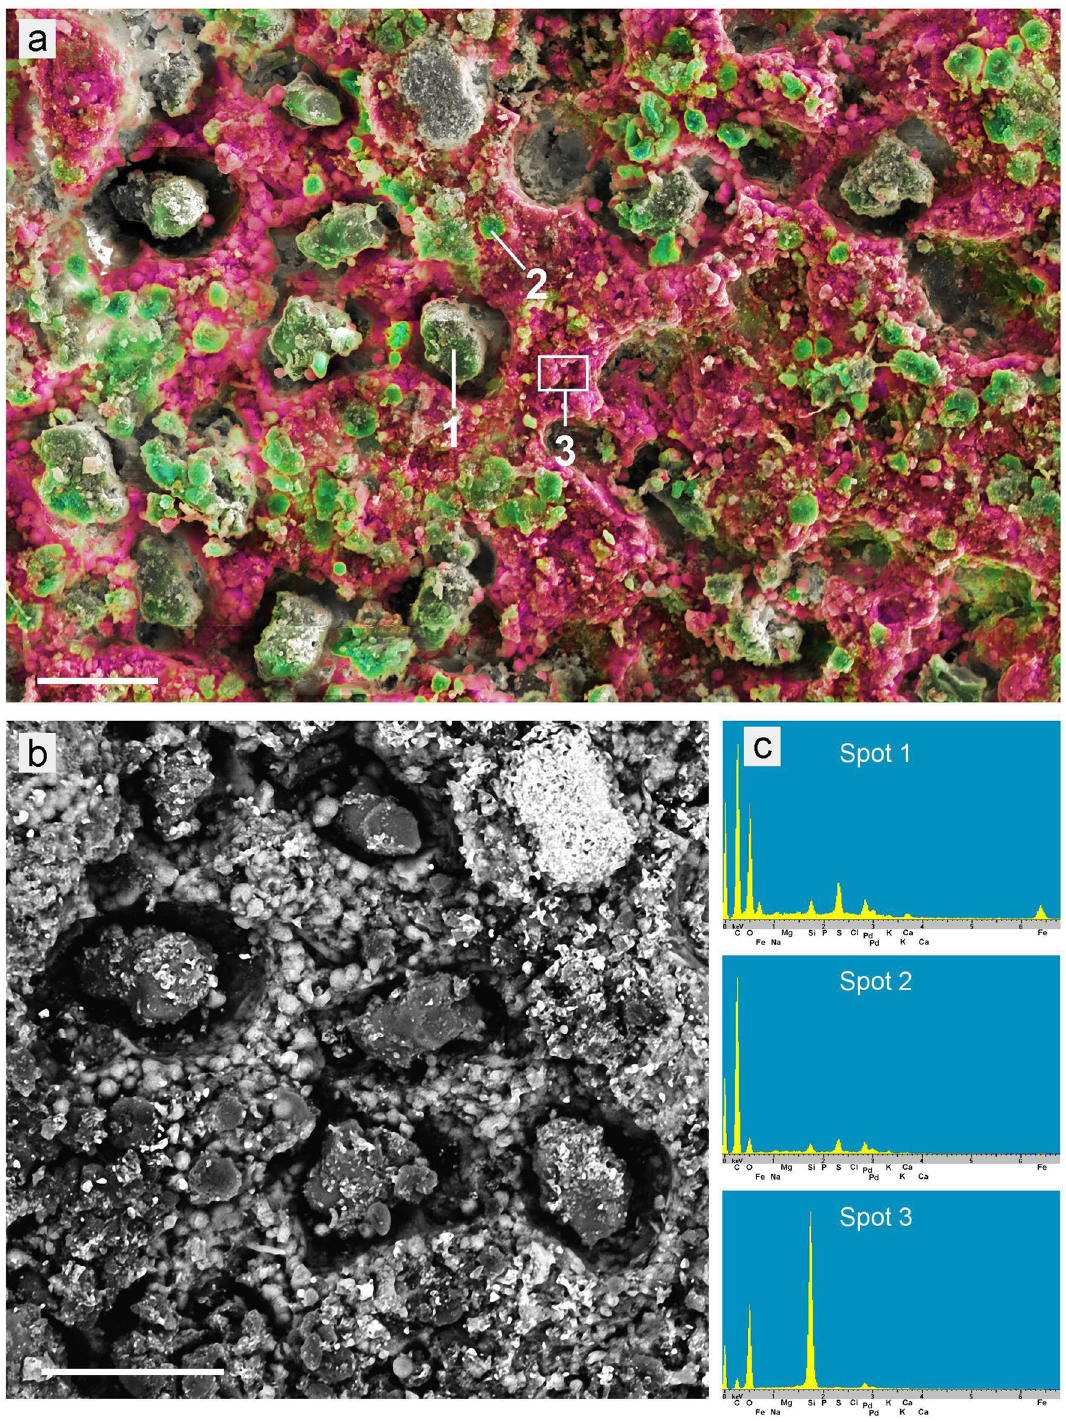
Figure 5. Element distribution in the fossil sample ‘Ro-13.3’ (‘ Nymphaea nymphaeoides’ ). ( a ) Combined SEM topographic contrast and element-mapping image showing Si in red and C in green colours. Small globules of organic material (e.g., Spot 2) are difficult to recognise between other organic particles. ( b ) Detailed BSE image of a section of ( a ) illustrating the grainy opal-like structure of the background sediment. ( c ) EDX spectra show the composition of black granules (Spot 1: C, O, Fe, S), small globules (Spot 2: mainly C), and background sediment (Spot 3: Si, O). Scale bars: ( a , b ) = 40